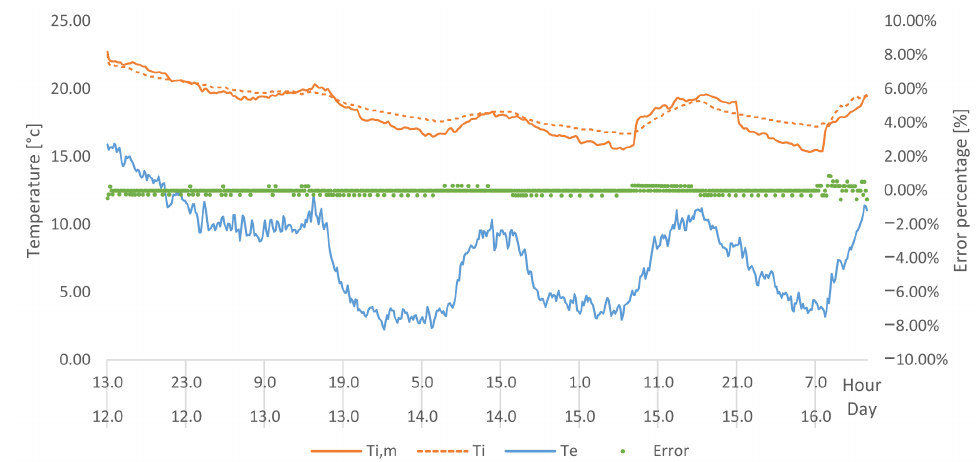
Figure 5. Experimental validation. Temperature profiles by measured data and TRNSYS simula- tions.